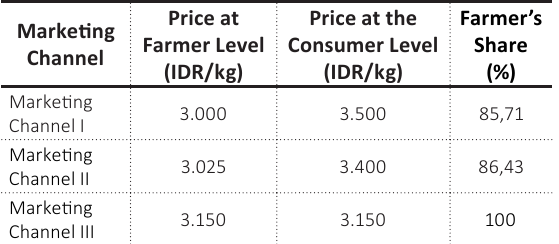
Table 7. Farmer’s share for each marketing channel in South Sulawesi Source: Primary data processed,